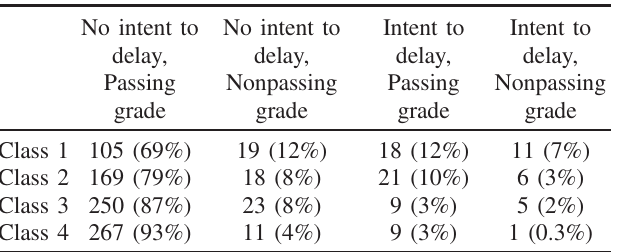
TABLE VII. Numbers and percentages of students according to intent to delay and grade listed by completion class. Intent to delay is defined here as having a mean intentional decision score of 5 or greater (on scale of 7), and a passing grade is defined here as C- (1.7 GP) or higher. Percentages are expressed in terms of completion class (i.e., by